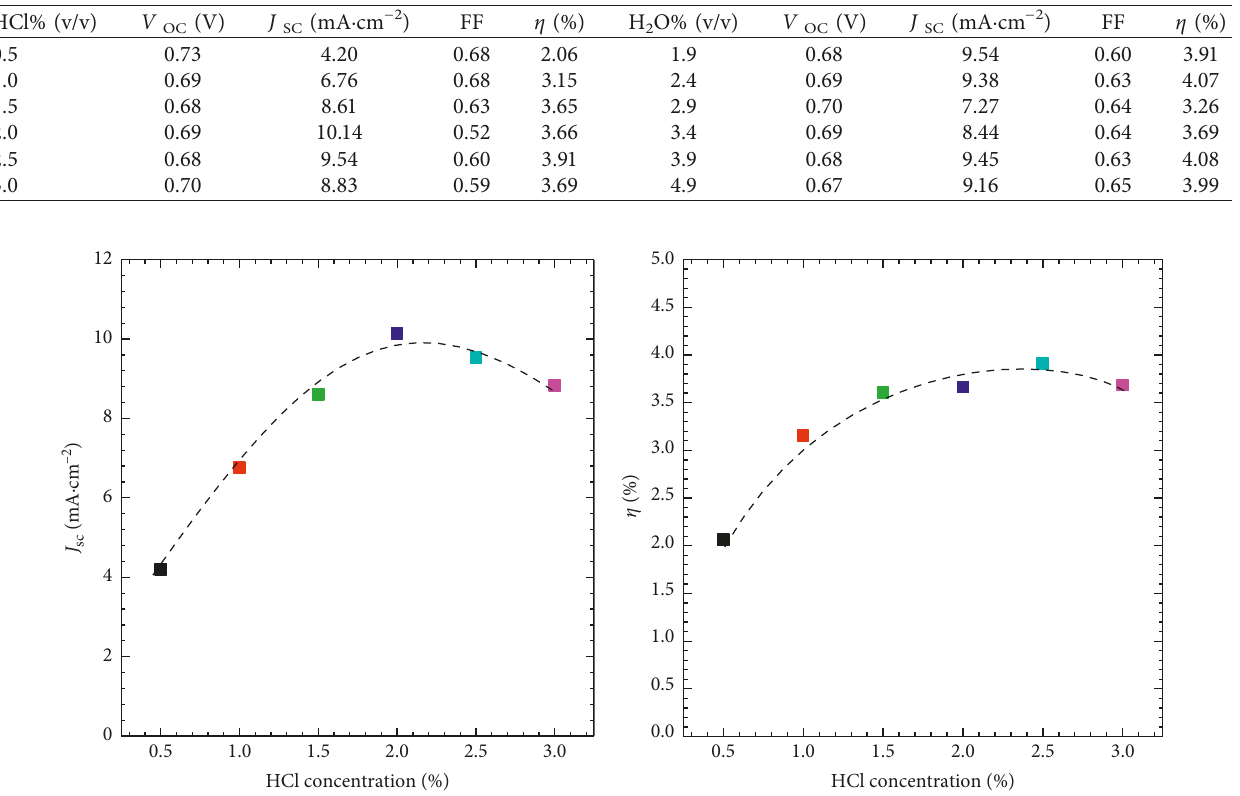
Figure 9: I-V curves of DSSC with n -type semiconductors prepared at different concentrations of HCl as a catalyst for the hydrolysis. Table 3: Performance parameters of solar cells. Left side: DSSCs utilizing TiO 2m synthesized via a sol-gel/solvothermal process at different HCl concentrations and at a 1.9% (v/v) H 2 O concentration and thermally treated in air at 530 ° C. Right side: DSSCs prepared from TiO 2m synthesized at different H 2 O contents and at a 2.5% (v/v) HCl concentration for the hydrolysis and thermally treated in air at 530 ° C.